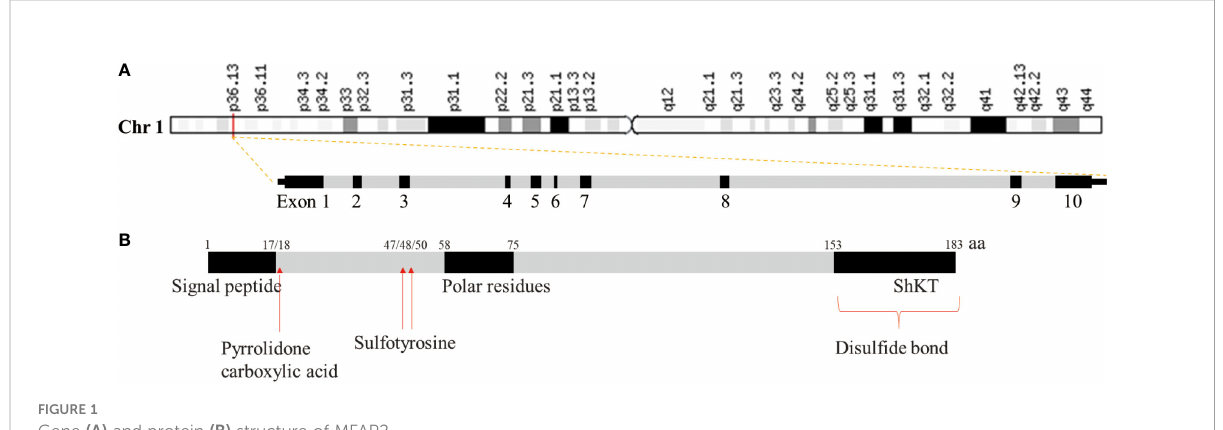
FIGURE 1 Gene (A) and protein (B) structure of